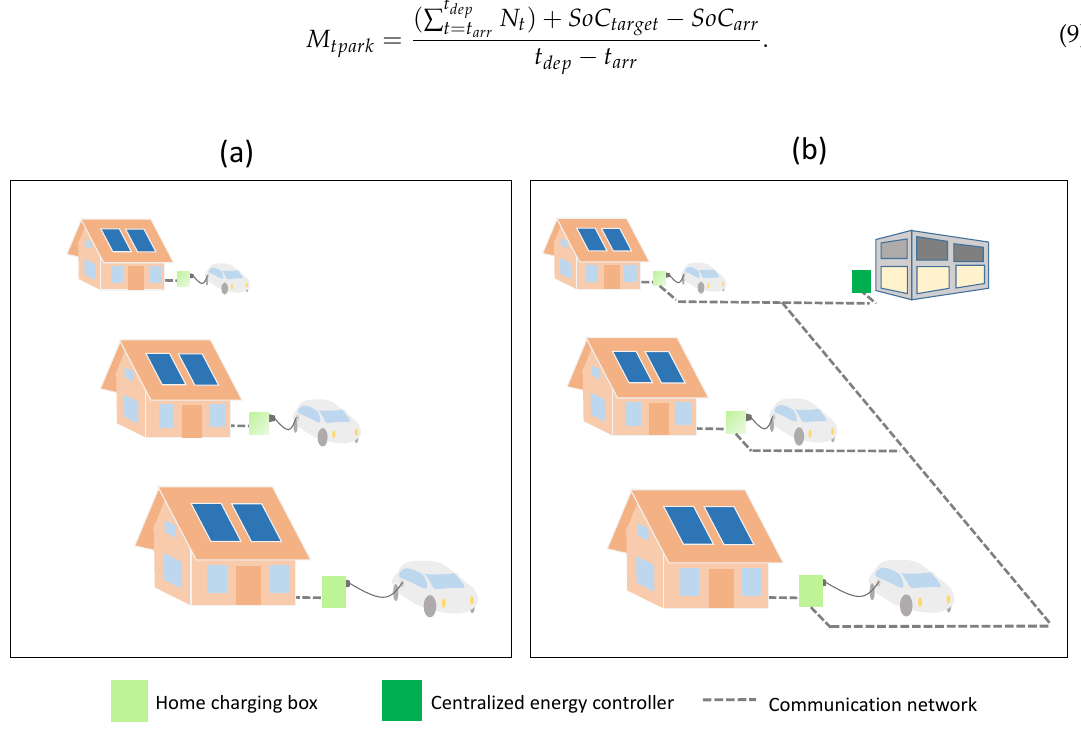
Figure 2. The architecture of ( a ) distributed/local and ( b ) centralized smart